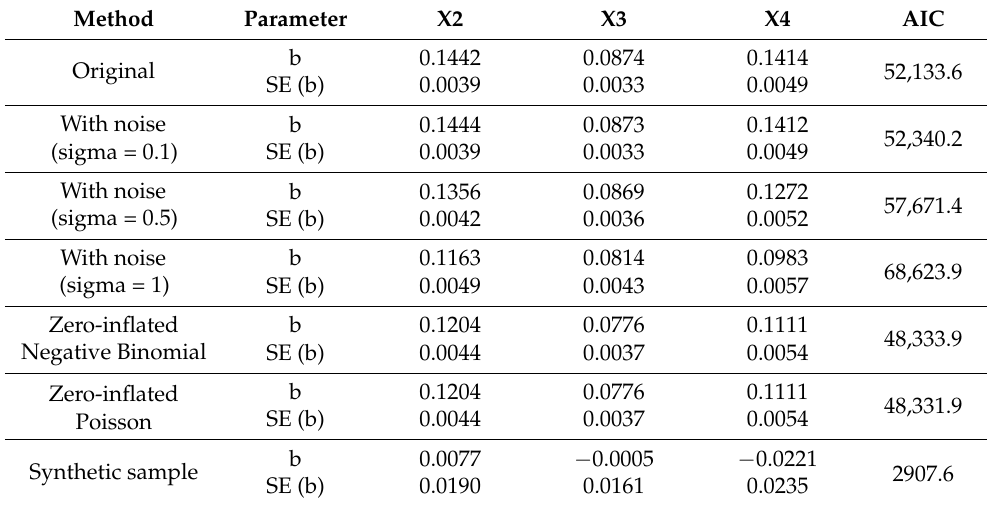
Table 5. Performance evaluation between comparative methods (simulation data 1 with high